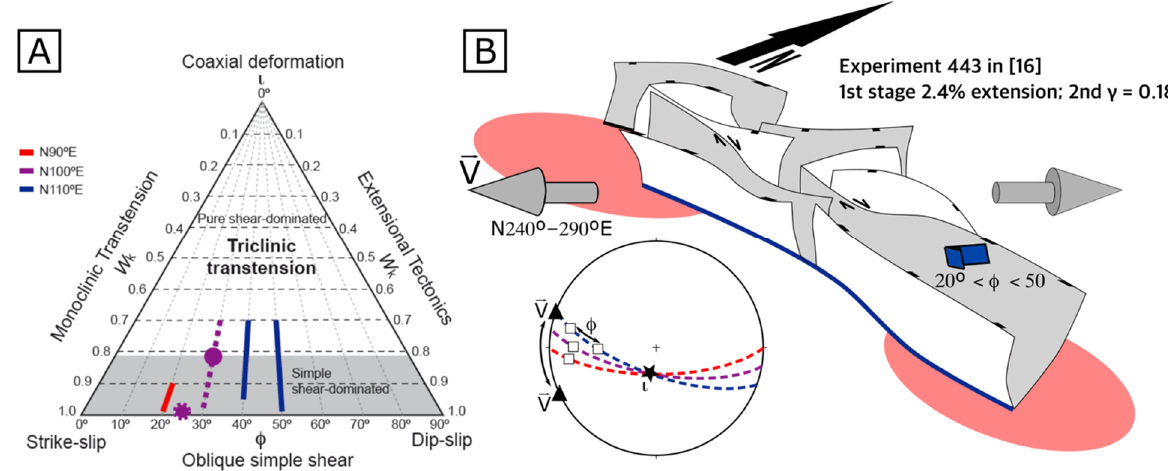
Figure 9. ( A ) Kinematic parameters deduced for the ESFZ plotted on the transpression/transtension deformation triangle. Colors depend on SZB orientation. The triangle is based on that of [9], modified by [12] and adapted for the transtension case. It incorporates dashed lines for transtension obliquity values ( ϕ , given in absolute value) and the kinematic vorticity number (Wk). Pure-shear-dominated transtension and simple-shear-dominated transtension areas are separated, according to [3], by the Wk > 0.81 gray area. ( B ) Three-dimensional sketch for the ESFZ modified by [16]. Sketch deduced from analogue modeling after 2.4% extensional stage and γ = 0.18 in a second stage. Stereoplot showing the best-fit results obtained after the transtension model application.